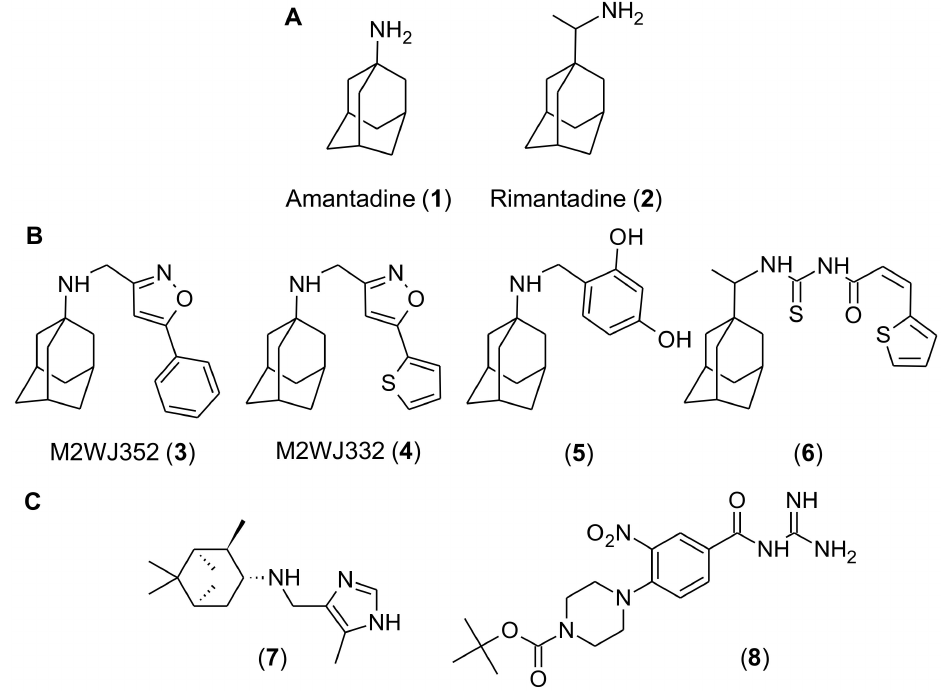
Figure 1. ( A ) Chemical structures of amantadine and rimantadine. ( B , C ) M2(S31N) inhibitors assembled for VS and determination of shared pharmacophores. Inhibitors were grouped into adamantine ( B ) and non-adamantane ( C )-class